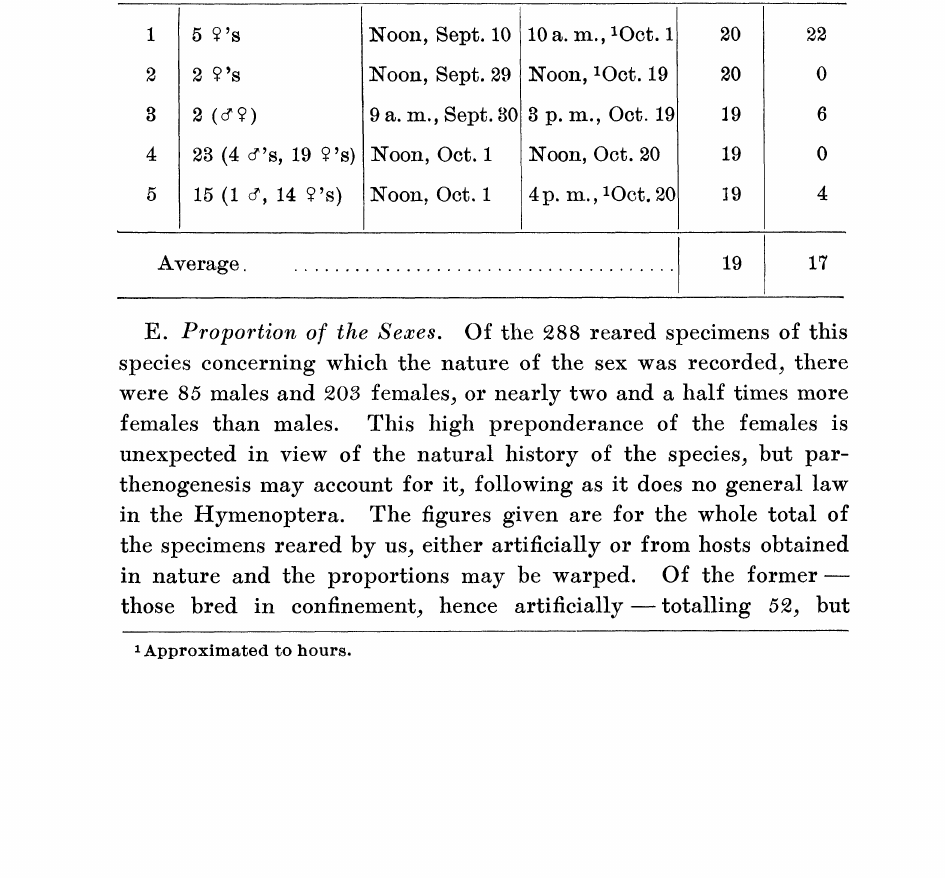
TABLE I. DURATION OF TttE LIFE CYCLE IN Muscidfurax raptor, SEVERAL CYCLES, 1908. Eggs Lot :Number of No. Progeny.